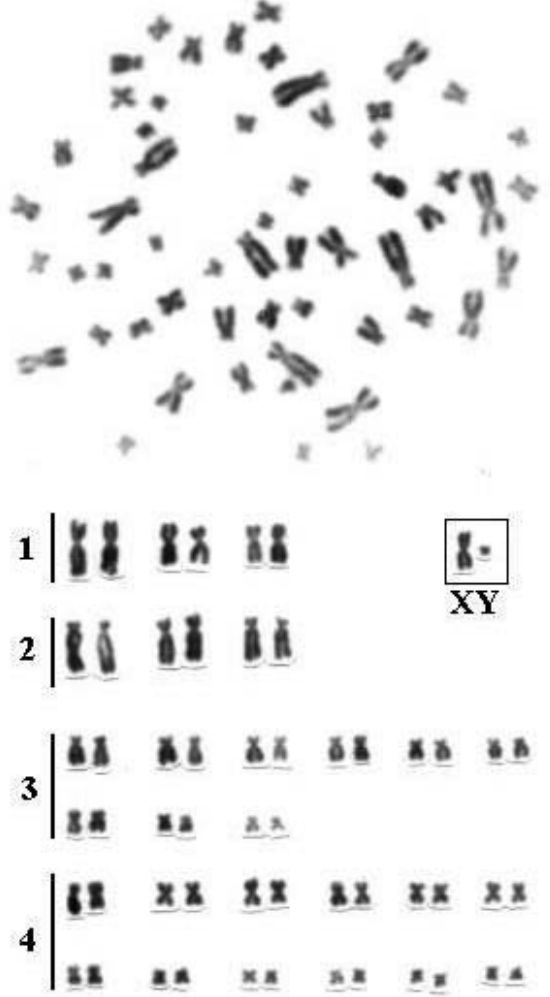
Figure 2 - Karyotype of Myrmecophaga tridactyla with 2n = 60 chromo- somes showing the X and Y chromosome morphology. The two X chro- mosomes of a female are exhibited in the karyotype.